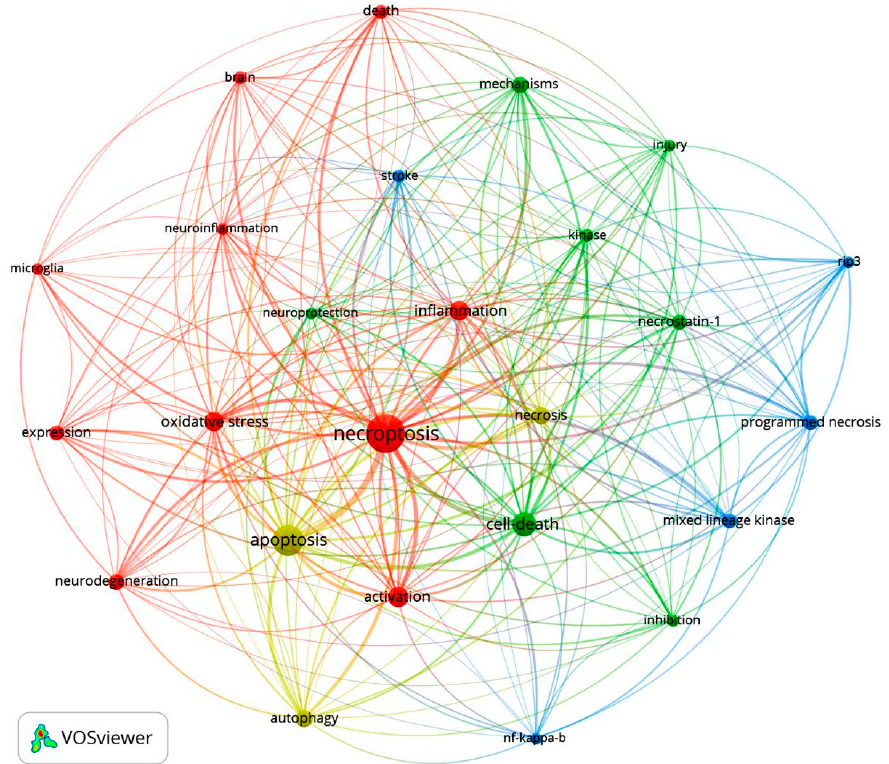
Figure 4. Co-occurrence network of keywords in necroptosis research established using the VOSviewer software. Four categories of necroptosis-related keywords are shown in red, blue, green and yellow. The red clusters are largest, and ‘necroptosis’ constitutes the largest node. Keywords associated with neuroinflammation and neurodegeneration such as ‘inflammation’, ‘oxidative stress’, ‘activation’ and ‘neurodegeneration’ are also